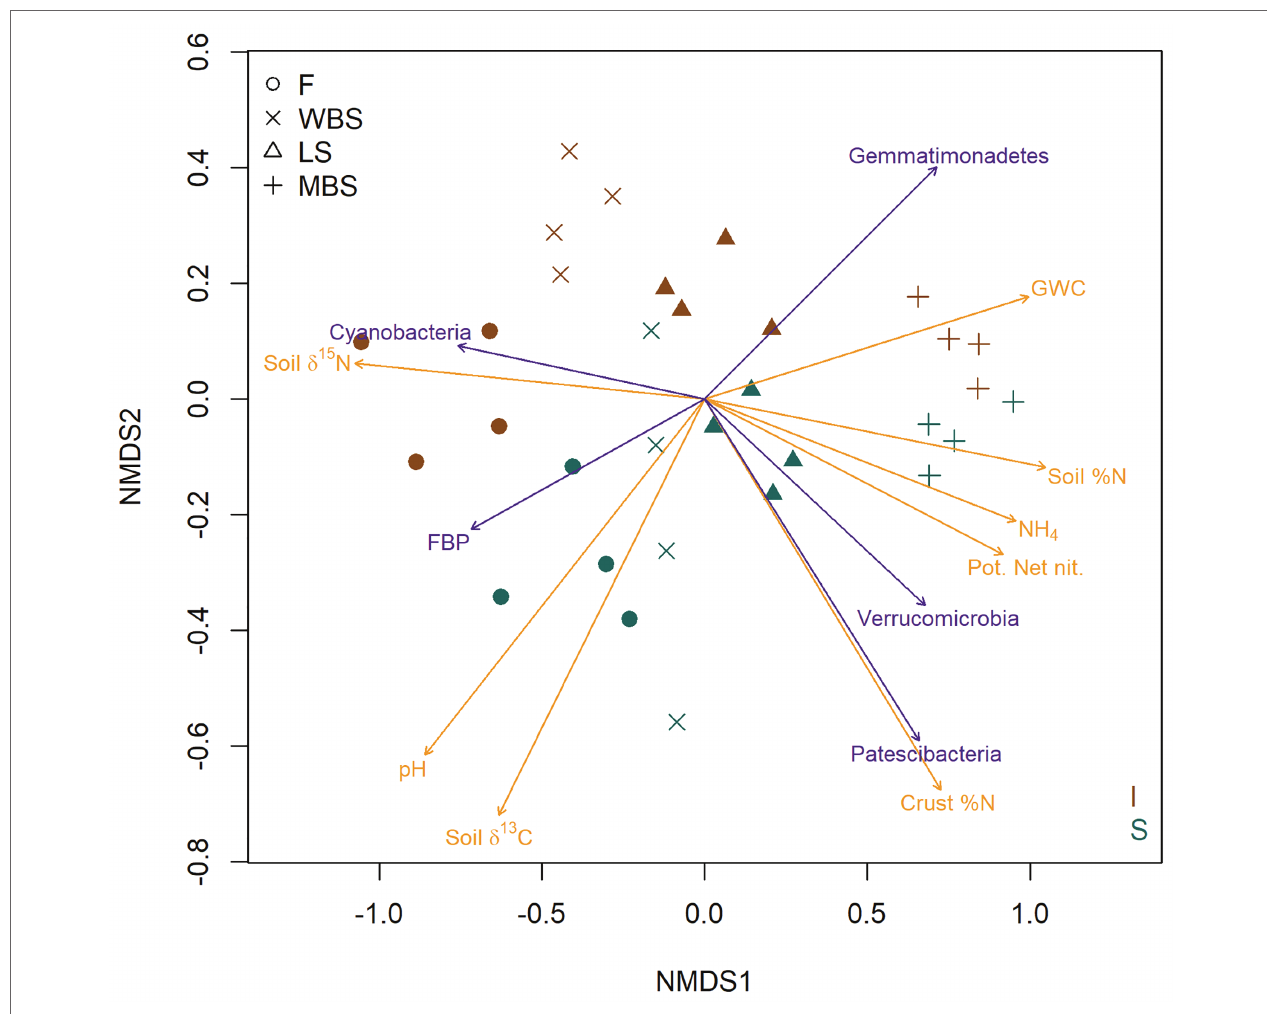
FIGURE 5 | Nonmetric multi-dimensional scaling (NMDS) ordination (stress = 0.089) based on Bray-Curtis dissimilarities of BSC community OTU composition. Red symbols represent BSCs from understory shrubs (S); black symbols represent BSCs from intershrub spaces (I). Arrows delineate vector fits of strongly significant ( α = 0.001) biogeochemical variables (brown arrows) and bacterial phyla (green arrows) that are correlates of the NMDS projection. Arrow direction indicates the direction of most rapid increase for a denoted variable in the projection. Arrow length is scaled by the strength of association ( R 2 ) of a multiple regression in which ordination axes serve as predictors for the variable indicated with an arrow. GWC, gravimetric water content; Pot. Net. Nit., potential net